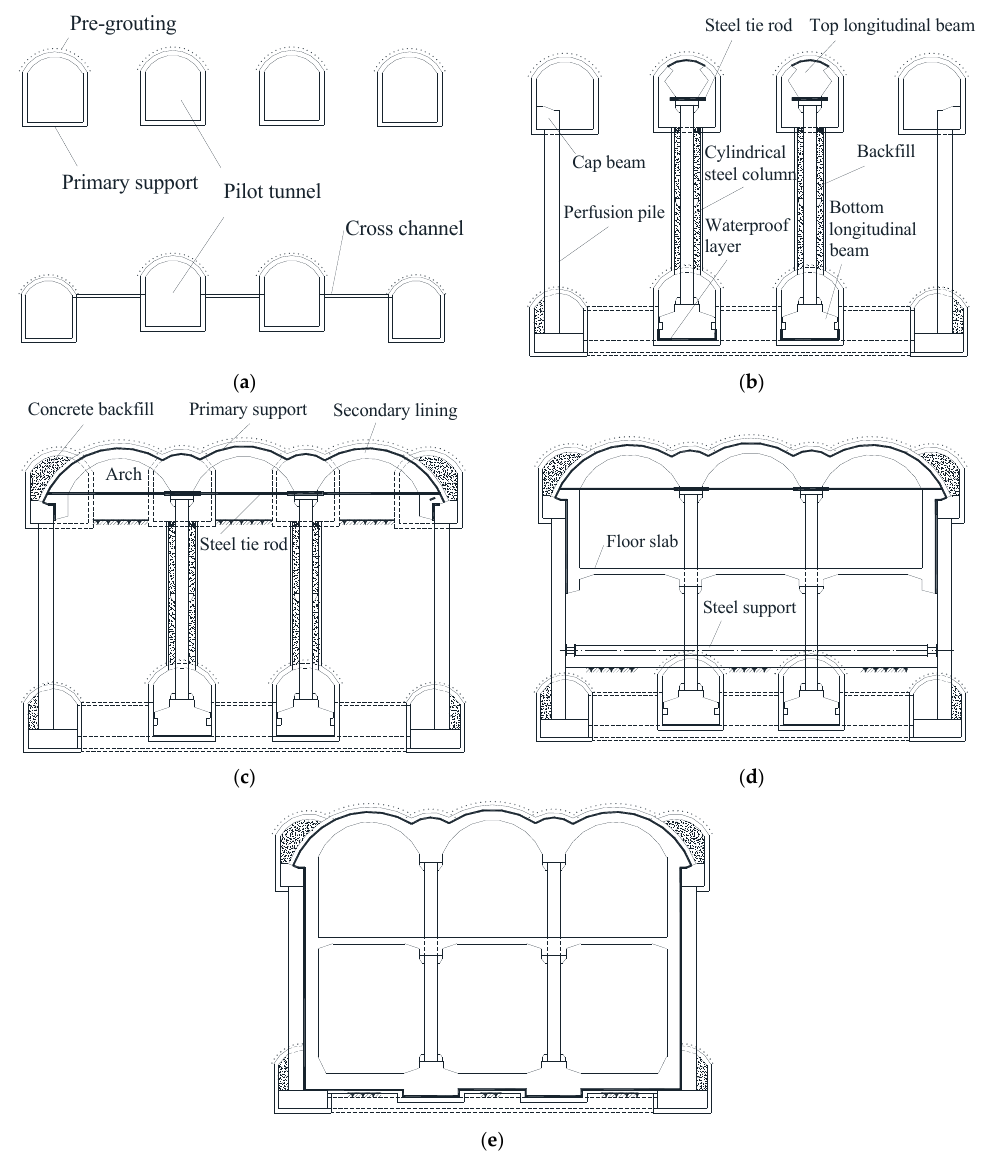
Figure 1. Subway station by the pile-beam-arch method: ( a ) Pilot tunnels construction, ( b ) Perfusion pile construction, ( c ) Arch construction, ( d ) Floor slab construction, ( e ) Completed